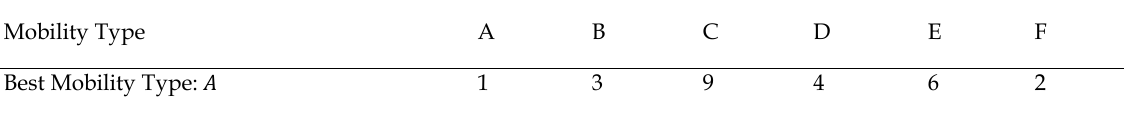
Evaluating all mobility types comparing to the best mobility type Mobility Type